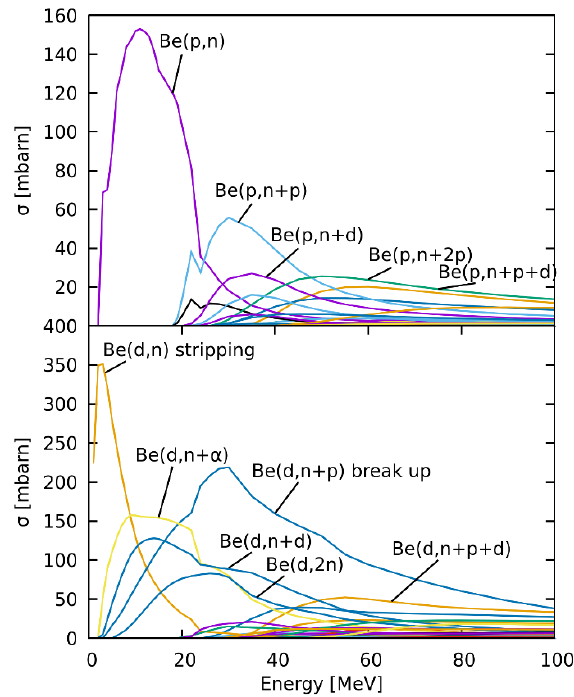
Figure 1: Cross sections for (p, n) reactions (top) and (d, n) reactions (bottom) in beryllium according to the TALYS nuclear code